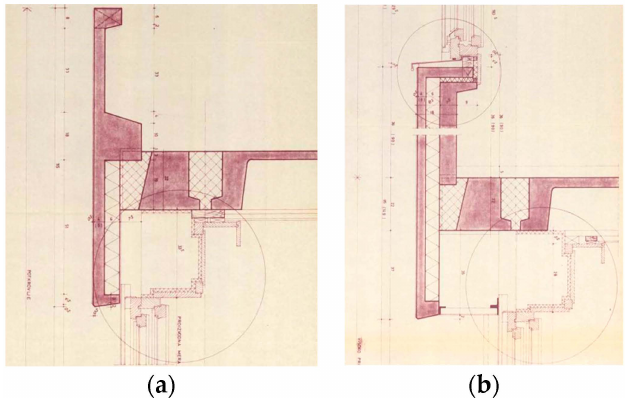
Figure 15. Façade cladding system: ( a ) Connections with roof slab ( b ) Joint between floor slab and parapet panel (source: original drawing sheet from Historical Archives of New Belgrade, 1970).